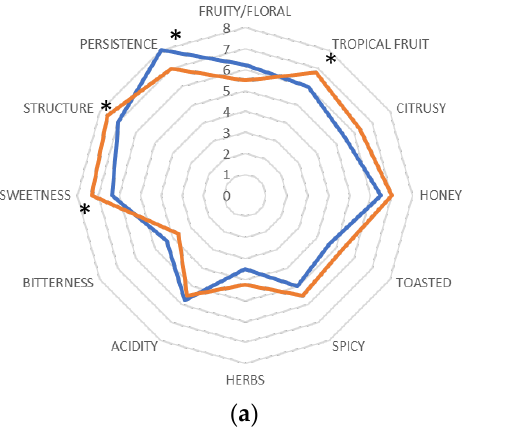
Figure 4. Sensory analysis of Verdicchio wine coming from 2021 vintage ( a ) and 2022 vintage ( b ). control trial;